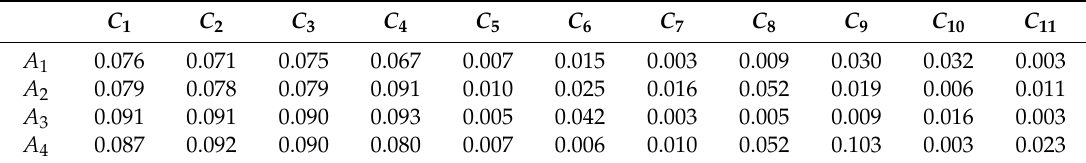
Table 11. Weighted Normalized Decision Matrix.